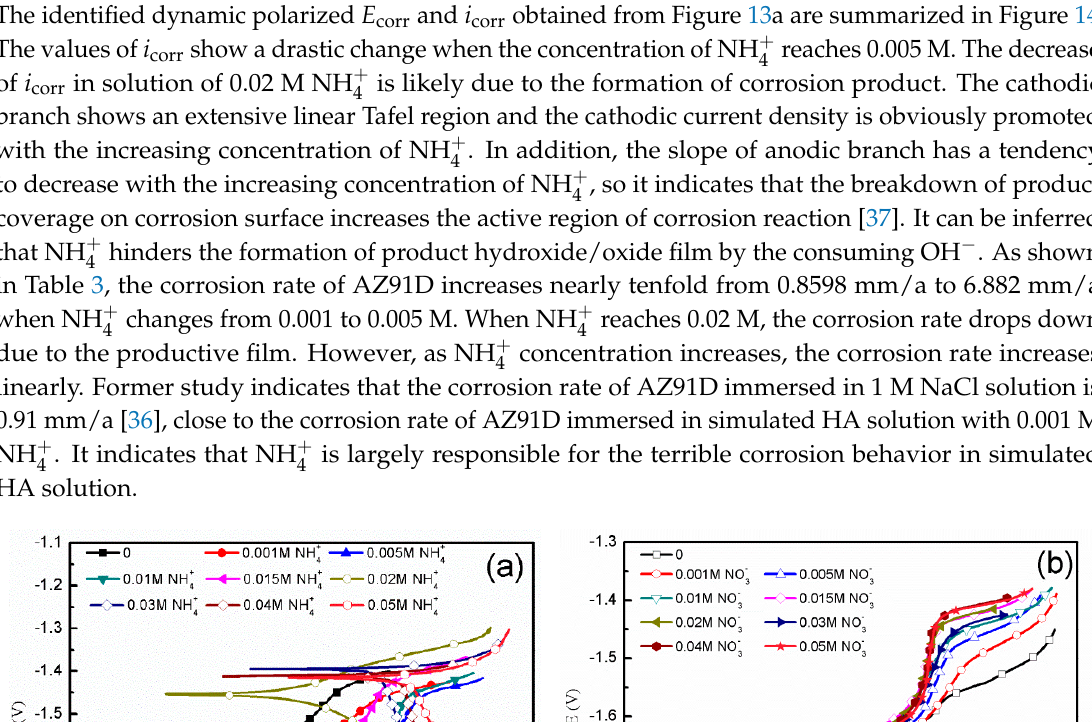
( a ) and NO - ( b ) concentration. 4 3 ( a ) and NO − ( b ) concentration. 3 4